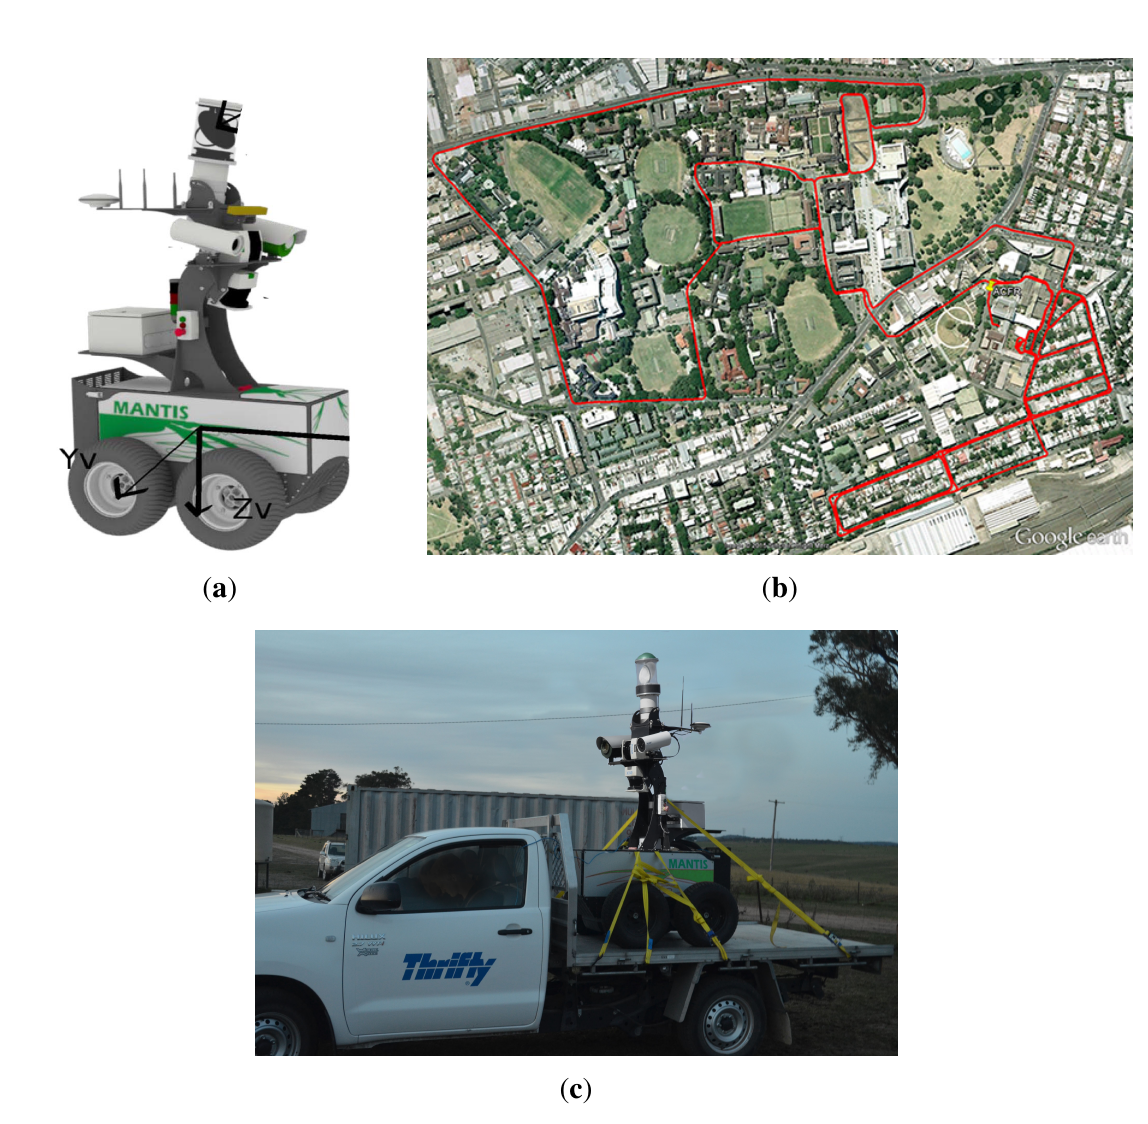
Figure 9. The experimental platform Mantis ( a ); urban path followed during the experiment ( b ); performed by fastening Mantis on a manned utility vehicle ( c